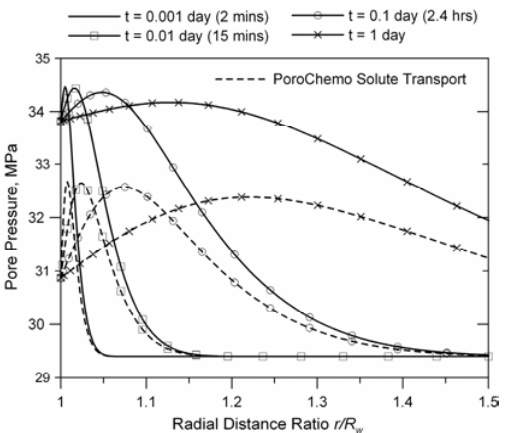
Fig. 4 – Pressure distribution in the formation at various time intervals into drilling for high mud activity (low mud salinity): f . 93 > a f . 90. a o = 0 mud = 0